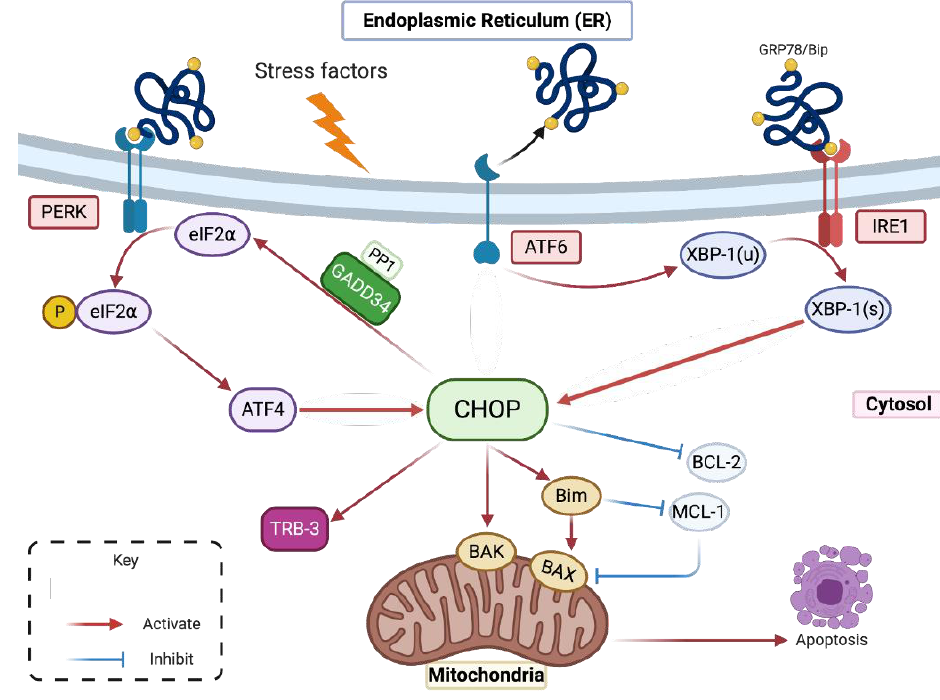
Figure 1. CHOP activation during ER stress and UPR (adapted from [18]).